Question: Name the type of graph shown.
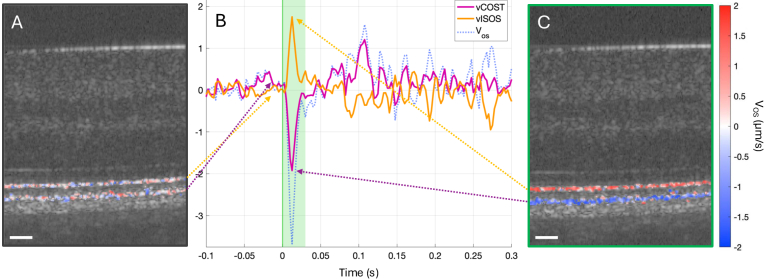
Answer: line